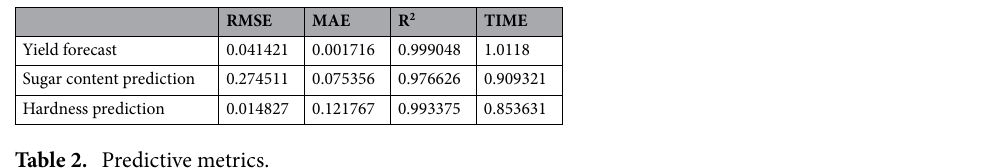
Table 2. Predictive